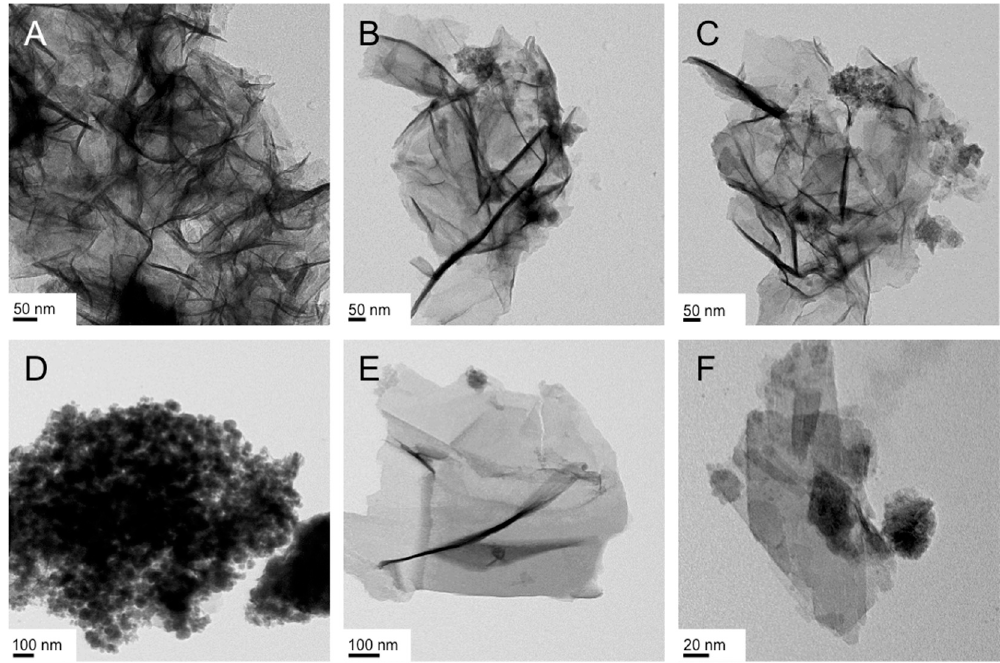
Figure 9. TEM images of the IO nanostructures obtained from the reduction/hydrolysis reaction of FeCl 3 in the isotropic micellar liquid (spherical micelles) formed by CTAB (3.6 wt %) in water at 50 °C: ( A – C ) froth fraction and ( D – F ) gel fraction.